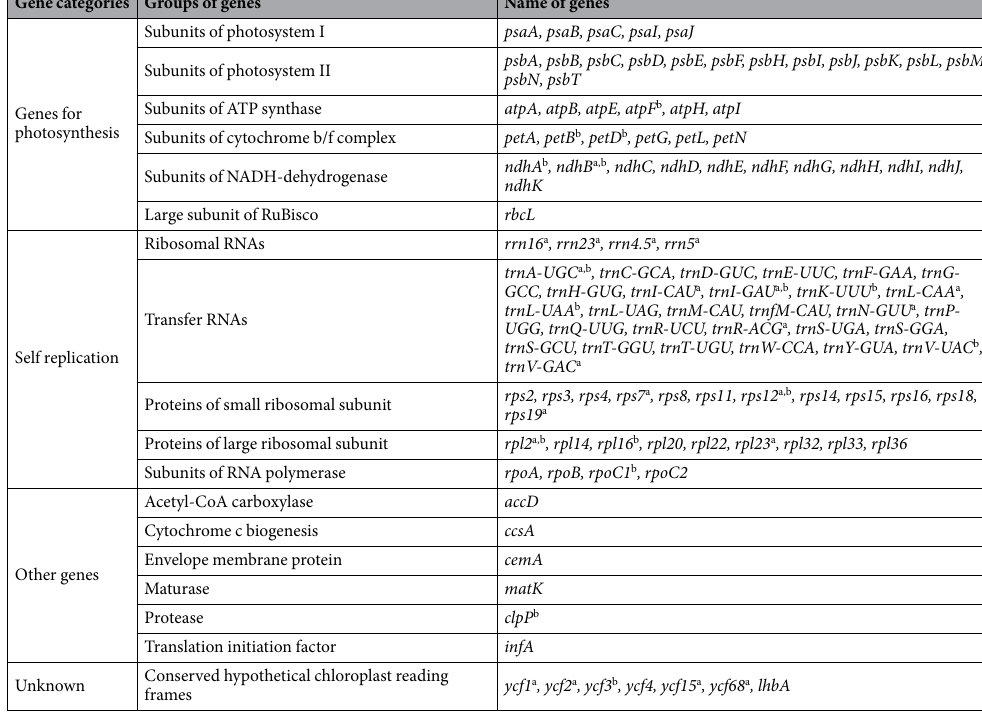
Table 2. Genes locating on tung tree cp genome. a Genes located in the IR regions. b Genes having introns.